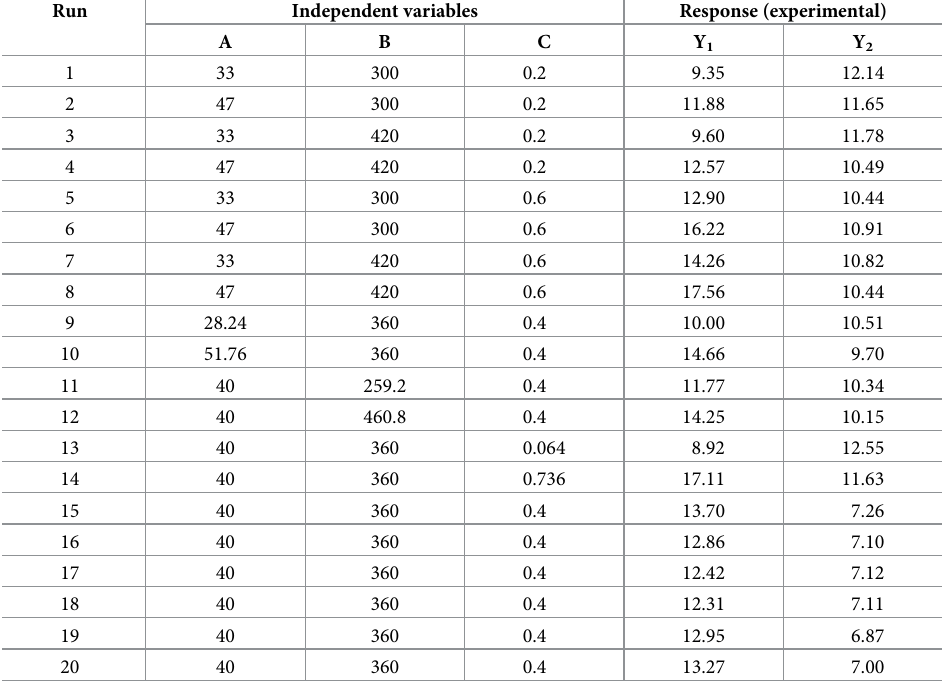
SBPH, the DH values were in the range of 8.92% to 17.56% and can be seen in Table 3, with the highest value derived from the eighth experimental run. In a study of DH values for salmon heads, Gbogouri et al . [36] reported similar findings, with values ranging from 11.5% to 17.3%. Table 3 also shows the ACE-inhibitory activity, with results in the range of 6.87 to 12.55 μ g/mL. Run 19 provided the lowest experimental value for ACE-inhibitory activity at 6.87 μ g/mL. The ANOVA results used p-values lower than 0.05 along with the estimated regression coefficients from the second-order polynomial model describing degree of hydroly- sis (Y ) or ACE inhibition (Y ), derived respectively from Eqs (4) and (5). Table 4 presents the 1 2 DH regression coefficients which indicate that the most significant effects resulted from the linear terms of temperature (A), time (B), and E/S ratio (C) (p < 0.0001 or p < 0.05) while the interactions among those variables (AB, AC, BC) as well as the quadratic terms (A 2 , B 2 , C 2 ) were shown to have effects upon DH which were not significant (p > 0.05). These findings demonstrate that the greatest influence upon DH was exerted by the linear terms of tempera- ture, E/S ratio, and time, while the regression coefficients associated with ACE inhibition Table 3. Results of the CCD for the values of the two response variables, which encompass %DH (Y 1 ), and ACE inhibitory activity (Y 2 ) under various reaction conditions pertaining to the three independent variables (A, B,